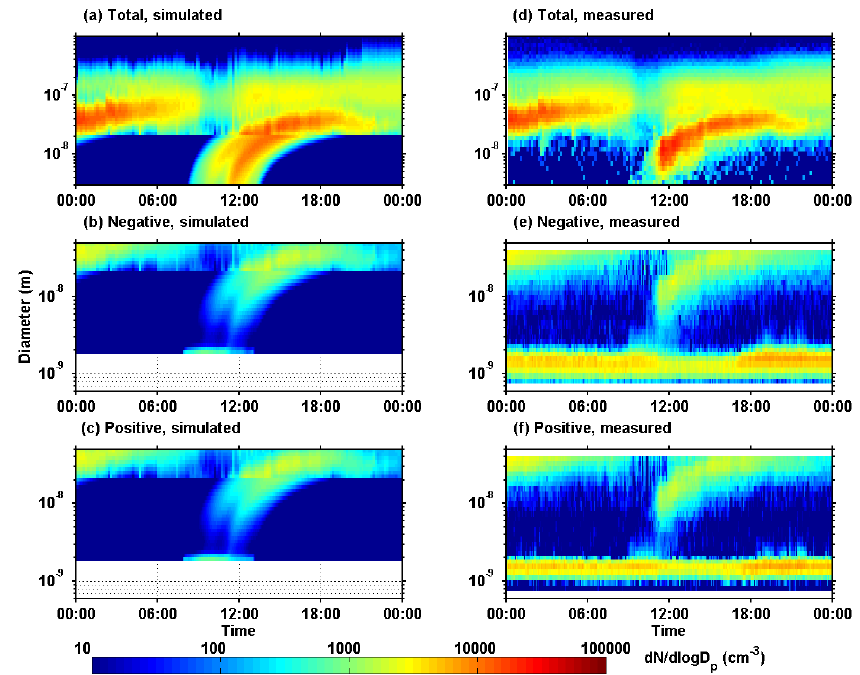
Fig. 9. Simulated (left panels) and measured (right panels) number size distribution of all particles (top row), negative ions (middle row) and positive ions (bottom row). The data represents the time evolution during a new particle formation event day (17 April 2007) in Hyytiälä, Finland.